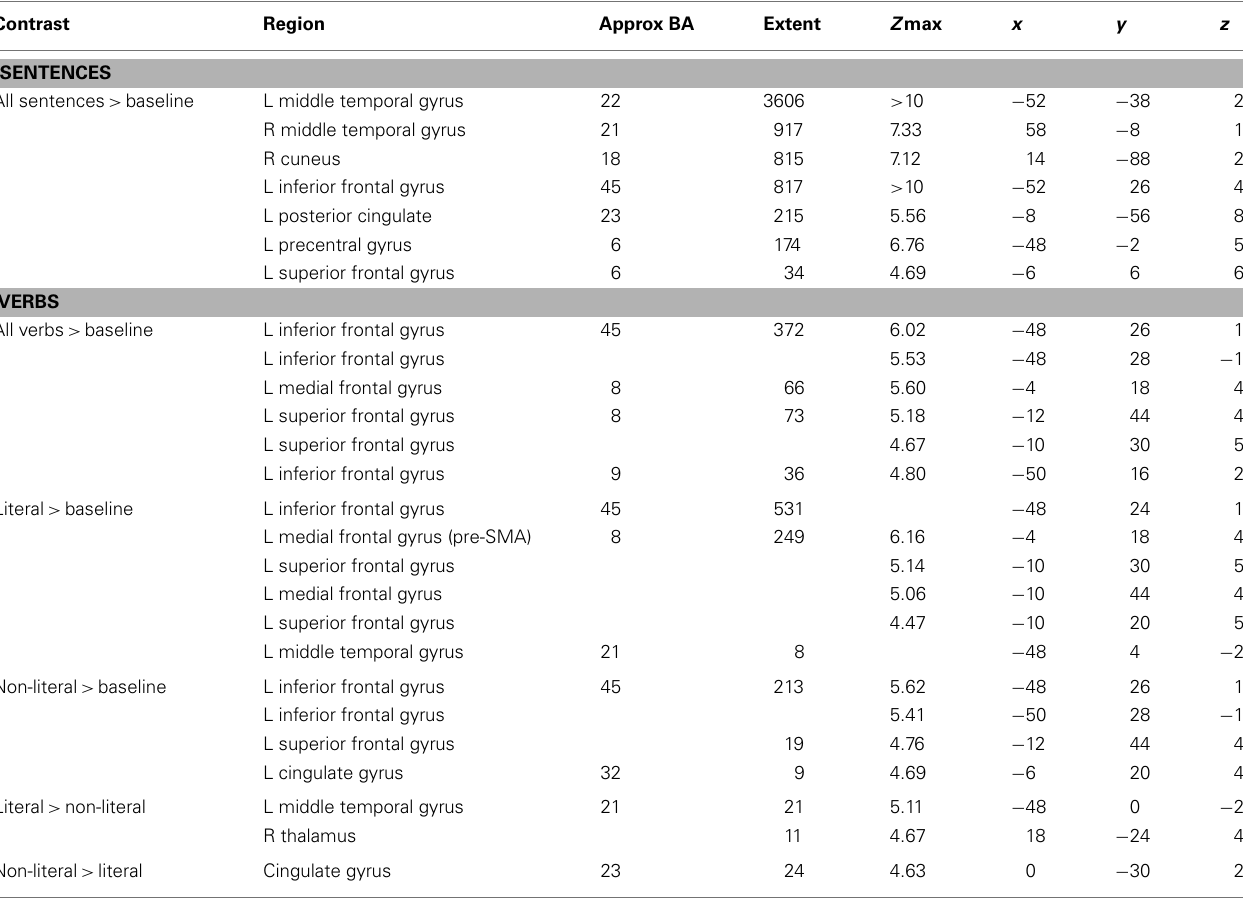
Table 4 |Whole brain